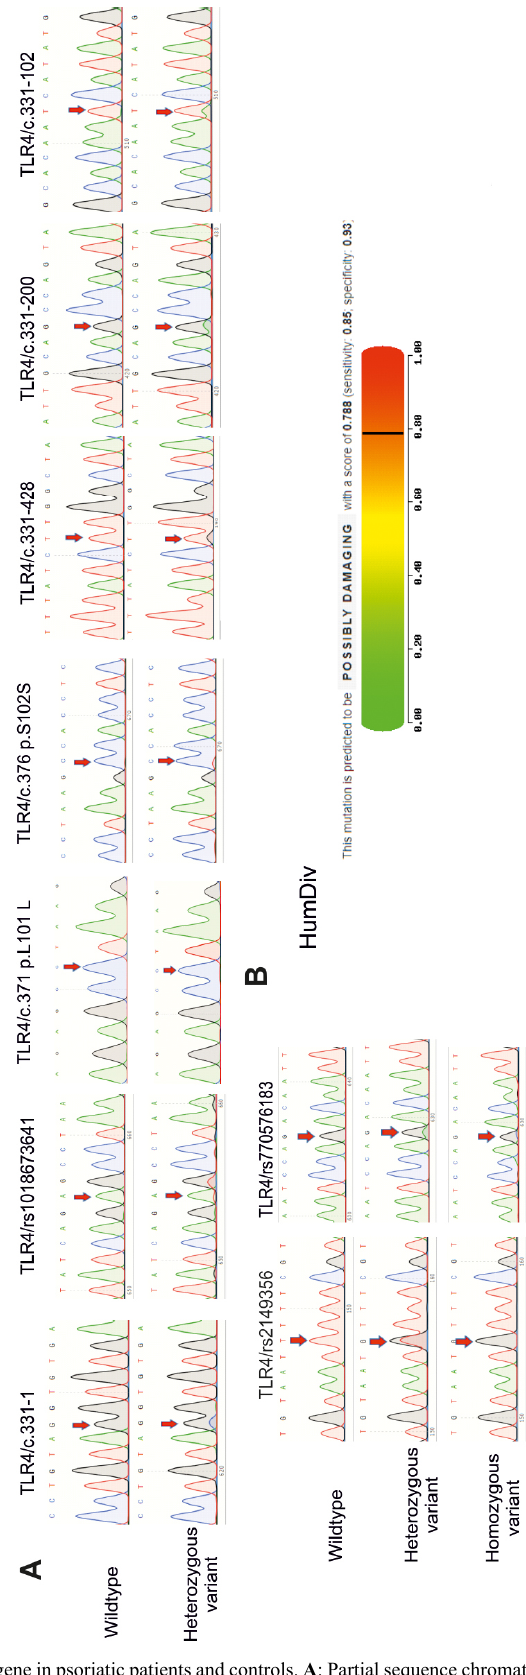
Figure 3 – Polymorphisms of TLR4 gene in psoriatic patients and controls. A : Partial sequence chromatograms of TLR4 gene from wildtype (1 st panels) and variant (2 nd and 3 rd panels) genotypes of the rs2149356 T>G, c.331-428 T>G, c.331-200 G>A, c.331-102 T>A, c.331-1 G>C, rs770576183 G>C/A, rs1018673641 A>T, p.L101L (c.371 C>T) and p.S102S (c.376 C>T) polymorphisms are shown. Arrows indicate the location of the base changes. B : Functional prediction of the SNP rs1018673641 by the Polyphen-2